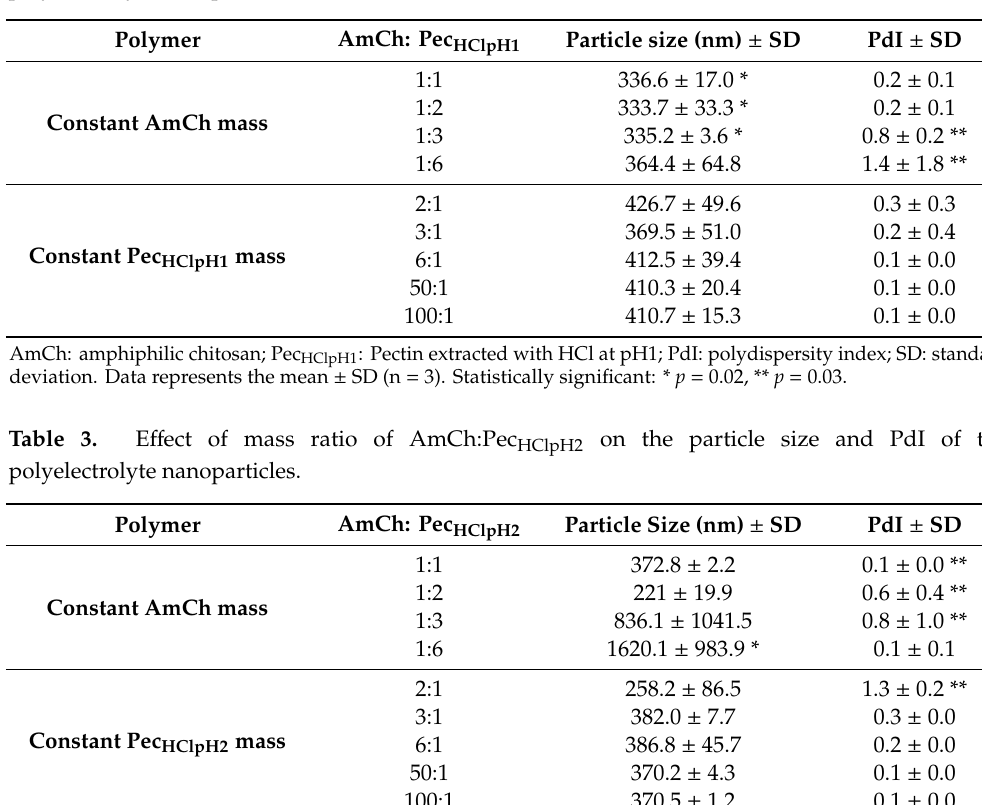
Table 2. E ff ect of mass ratio of AmCh:Pec HClpH1 on the particle size and PdI of the polyelectrolyte nanoparticles.